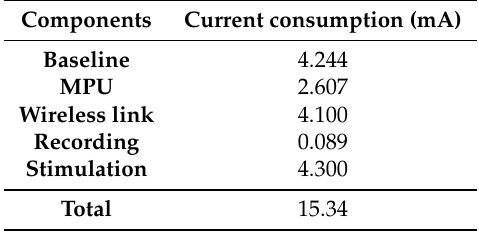
Figure 5. Current consumption under different system configurations. Table 2. Breakdown of the current consumption for the implantable BBMI